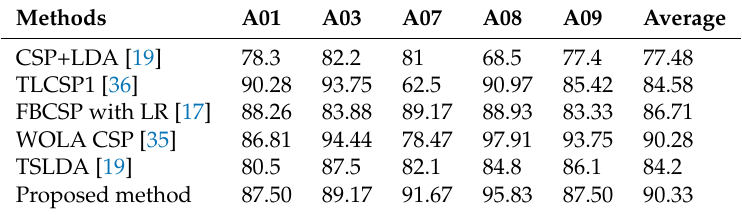
Table 7. The comparison of performance accuracy (%) with sophisticated methods (based on BCI